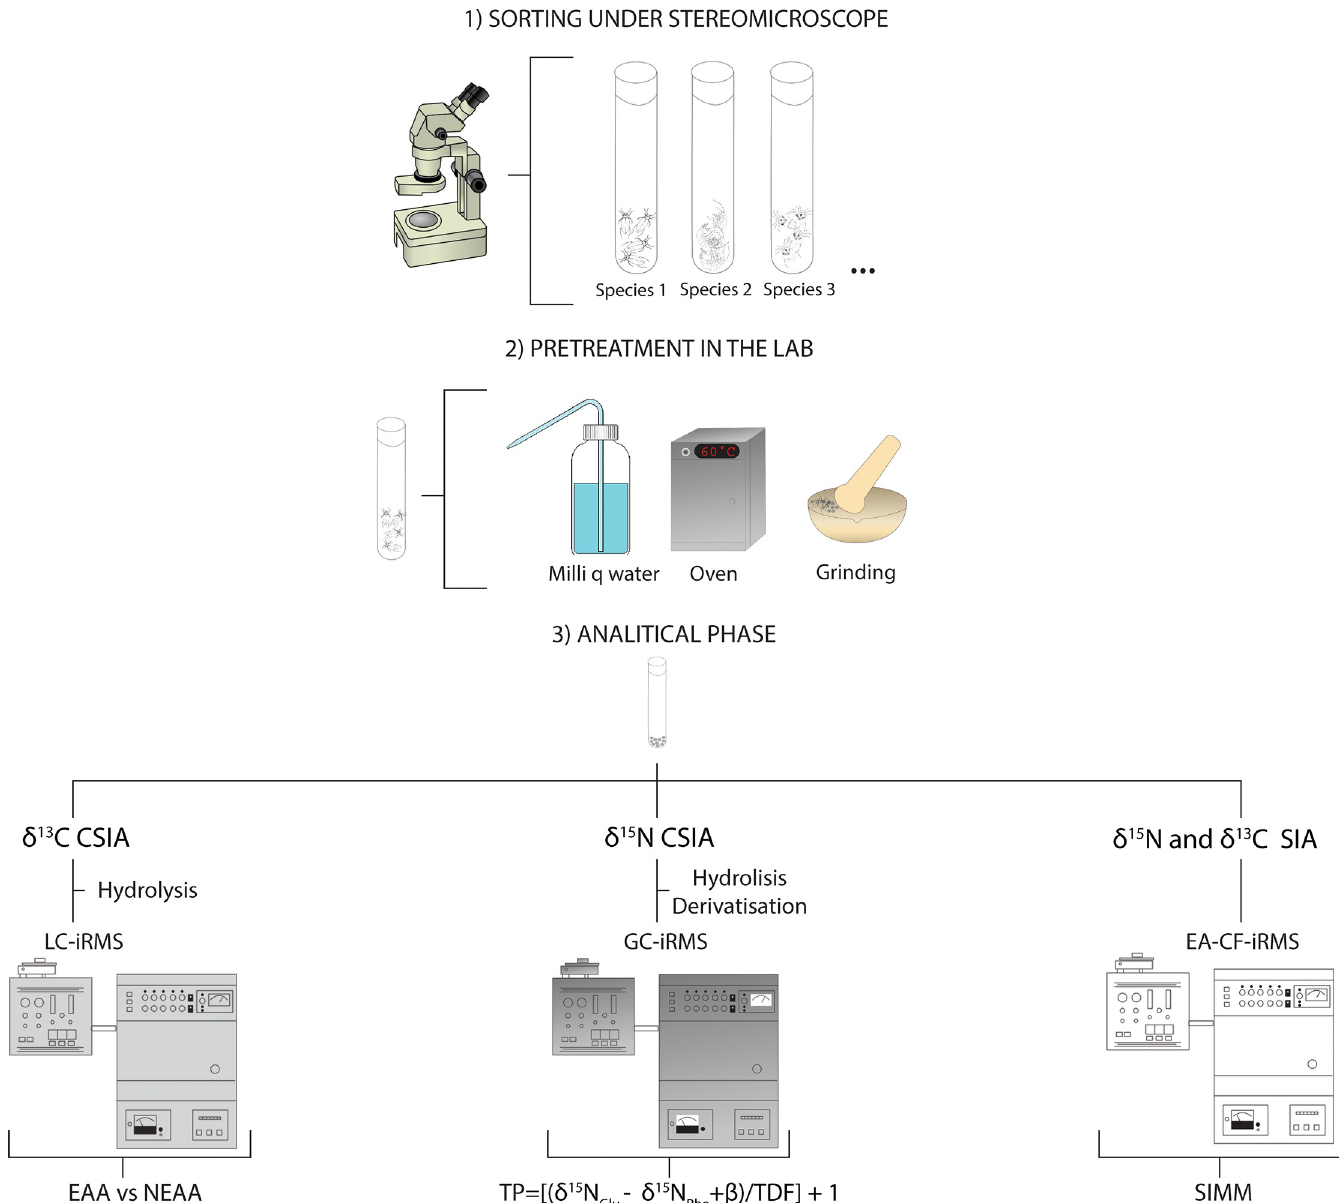
Fig 2. Methodological scheme of the study for stygofaunal samples (including copepods for bulk SIA). EAA: essential amino acids; NEAA: non-essential amino acids; TP: trophic position; TDF: trophic discrimination Factor; β = ratio between δ 15NGlu and δ 15NPhe values in primary producers; SIMM: stable isotopes mixing models; LC-iRMS: Liquid Chromatography-isotope Ratio Mass Spectrometry; GC-iRMS: Gas Chromatography-isotope Ratio Mass Spectrometry; EA-CF-iRMS: Elemental Analyser-Continuous Flow-isotope Ratio Mass Spectrometry.